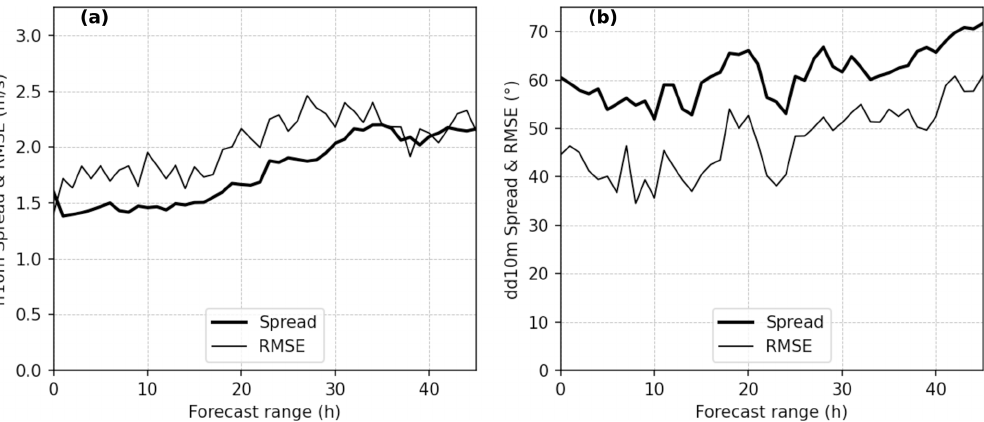
Figure 4. Ensemble spread and RMSE of the ensemble mean forecast for both 10m wind speed (referred to as ff10m) (a) and direction (referred to as dd10m) (b) aggregated from the two ground measurement stations: La Hague and Gonneville, as a function of the forecast